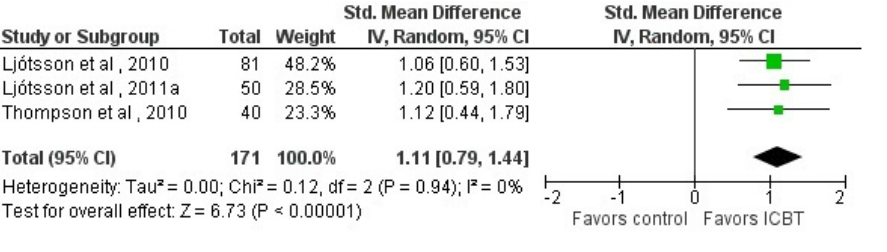
Figure 7. Forest plot of standardized mean differences of the effect on disease-specific quality of life of Internet-based cognitive behavioral therapy compared with a passive control condition.